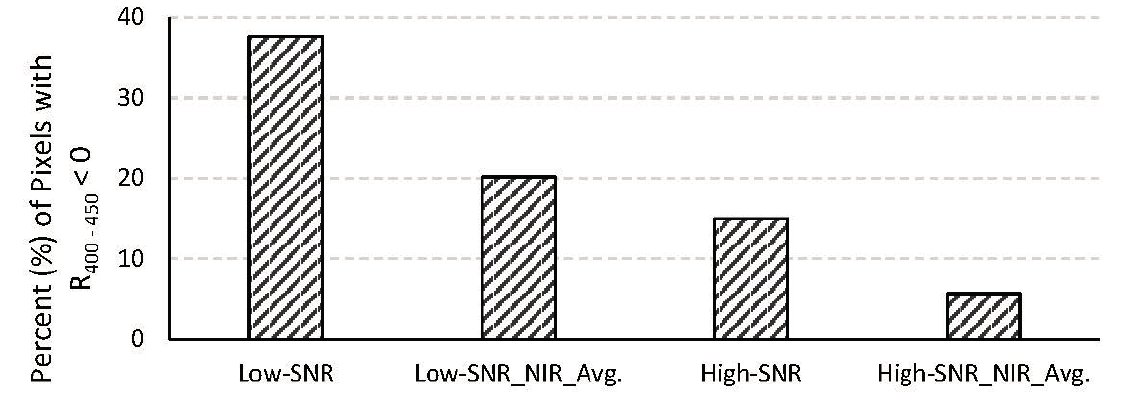
Figure 8. Average percentage of pixels with negative reflectances in the 400–450 nm region for the low- and high-SNR systems with and without spatial averaging in the NIR spectral